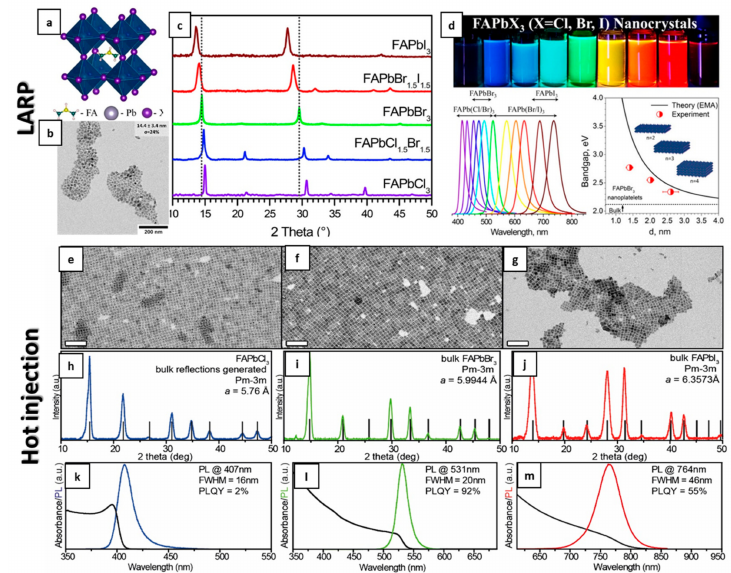
Figure 4. ( a – d ) FAPbX 3 NCs synthesized by LARP reproduced with permission from Ref.